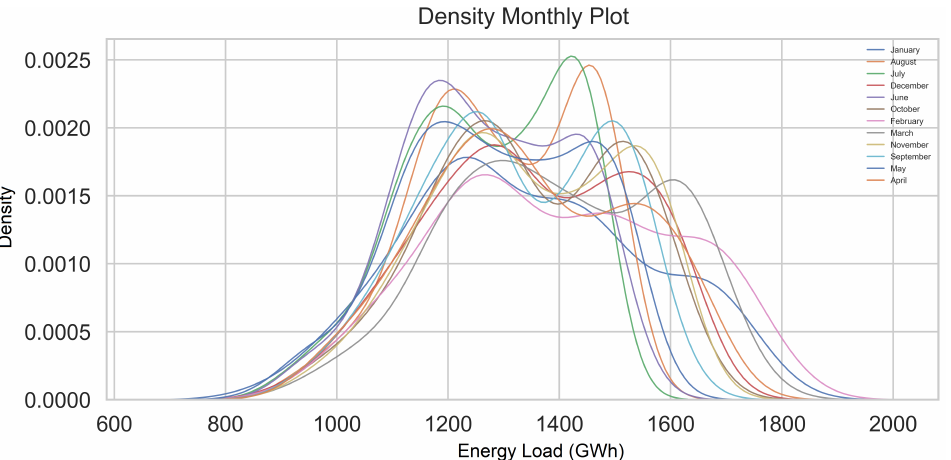
Figure 7. Density plot of monthly average distribution for the Energy Load .